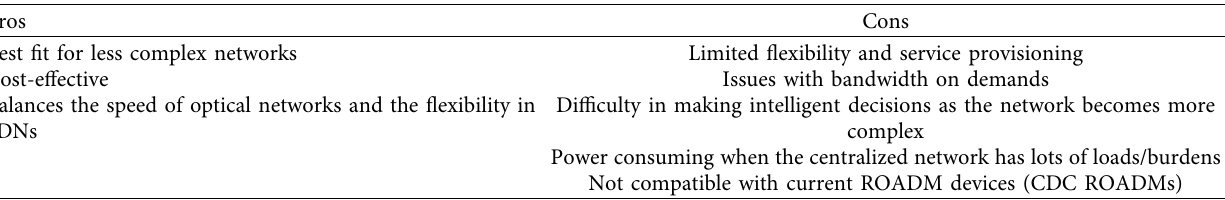
Figure 11: Duo-client standard SDON architecture. Table 5: Pros and cons of standard architecture table